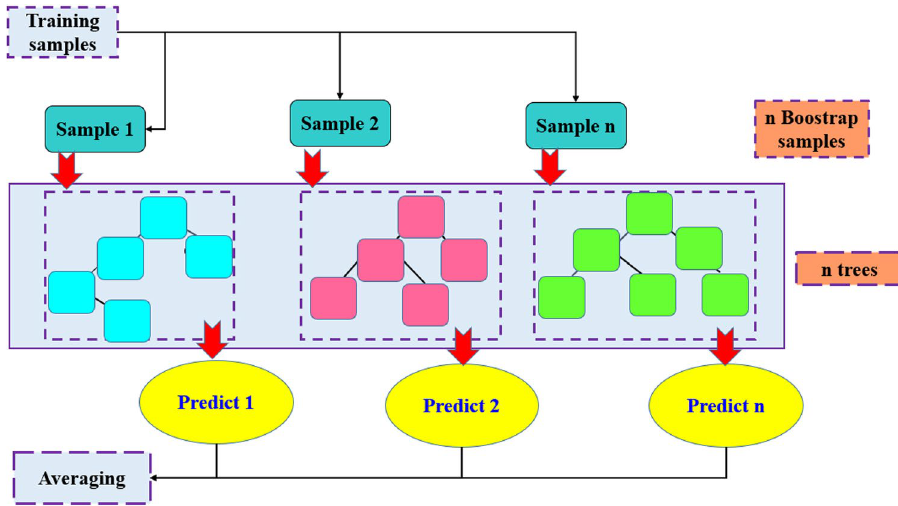
Figure 2. Graphical structure of RF